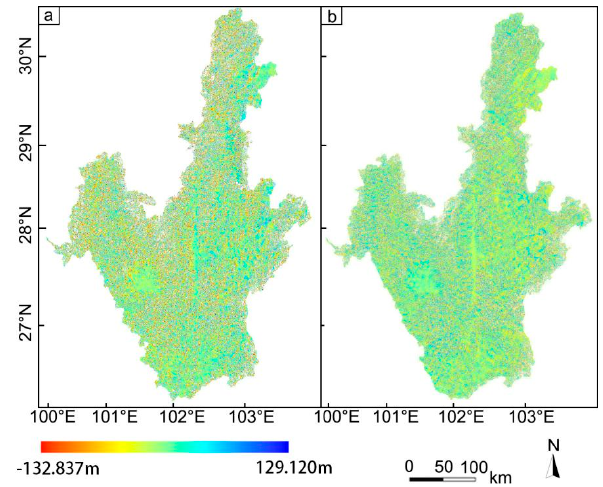
Figure 7. Topography changes revealed by the DEM data: ( a ) from 1992 to 2000; ( b ) from 2000 to 2009.